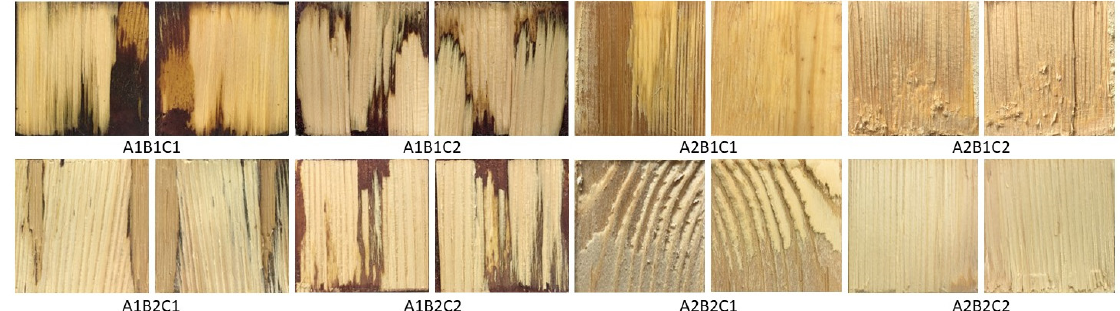
Figure 3. Dataset image type.